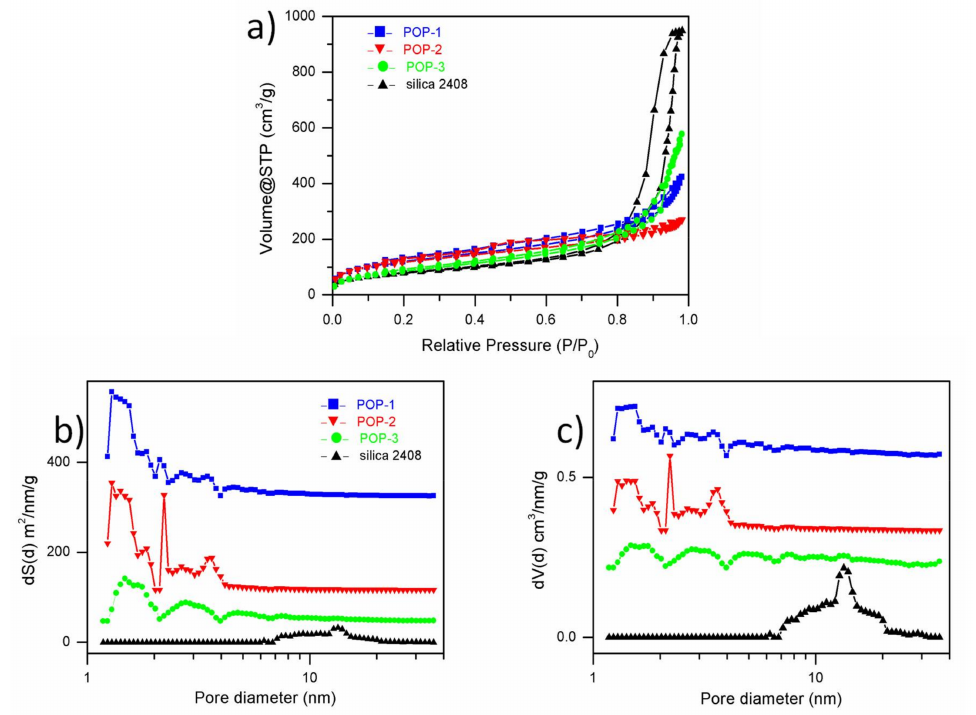
Figure 1. ( a ) N 2 isotherms. Non-local density functional theory (NLDFT) pore size distribution curves of ( b ) dS vs. d and ( c ) dV vs. d of POPs and silica